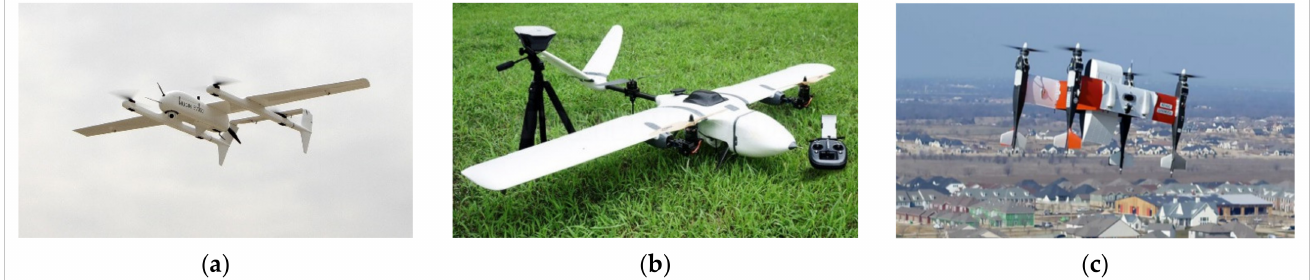
Figure 1. Various types of multi-mode aircrafts: ( a ) lift+cruise-type UAV, Mugin 350EV model [3]; ( b ) vectored-thrust-type UAV, Foxtech Nimbus VTOL V2 model [4]; ( c ) tail-seater-type UAV, Bell APT model